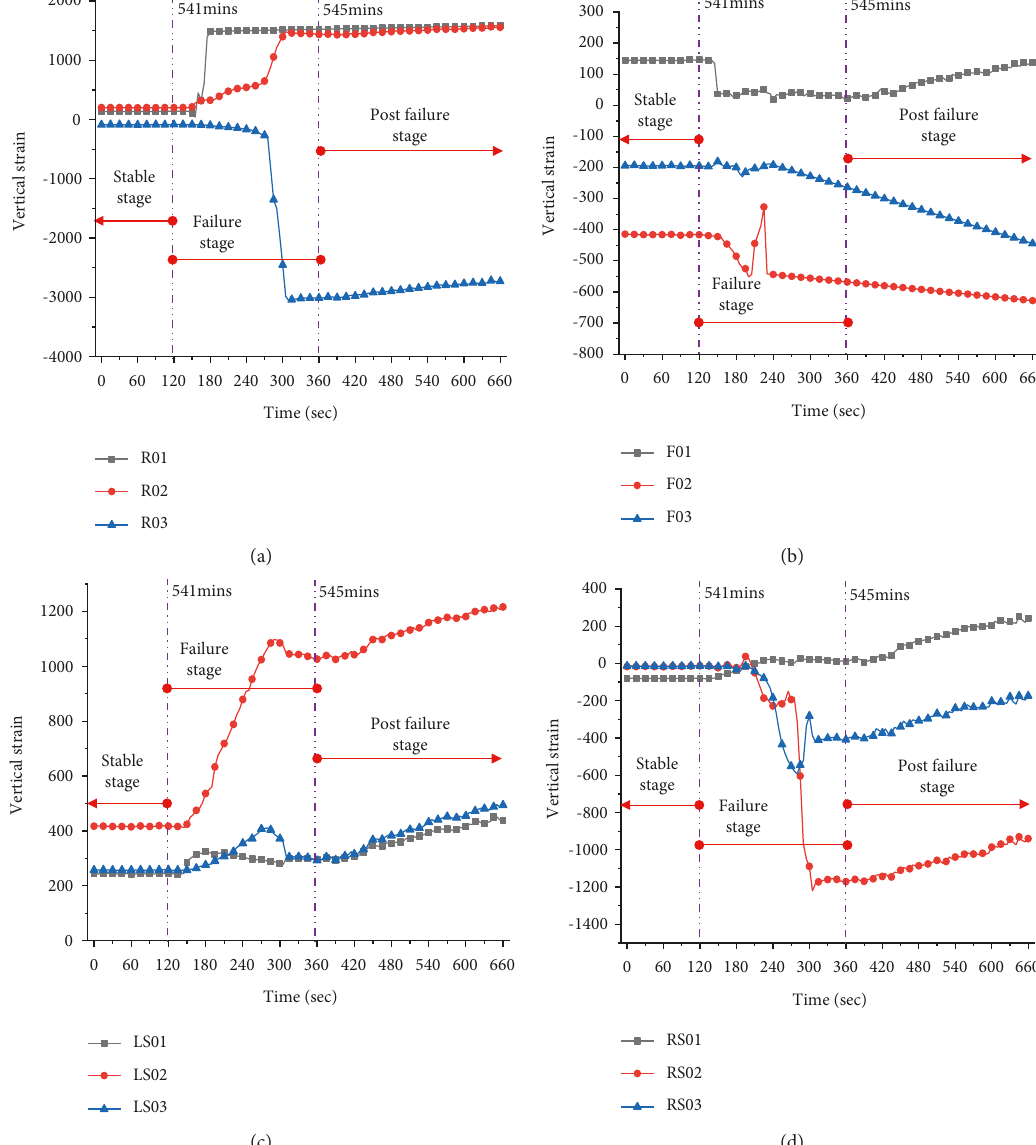
Figure 11: Vertical strain of measuring points when the cumulative duration is 539–550mins; (a) R01, R02, and R03; (b) F01, F02, and F03; (c) LS01, LS02, and LS03; and (d) RS01, RS02, and